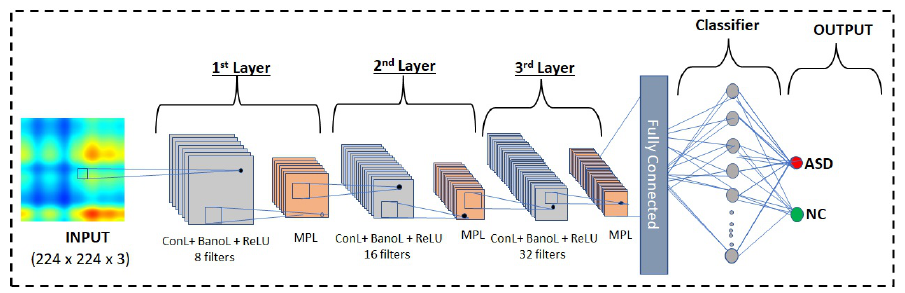
Figure 5. Structure of 3L-CNN for ASD diagnosis using FC-images of BOLD rs-fMRI